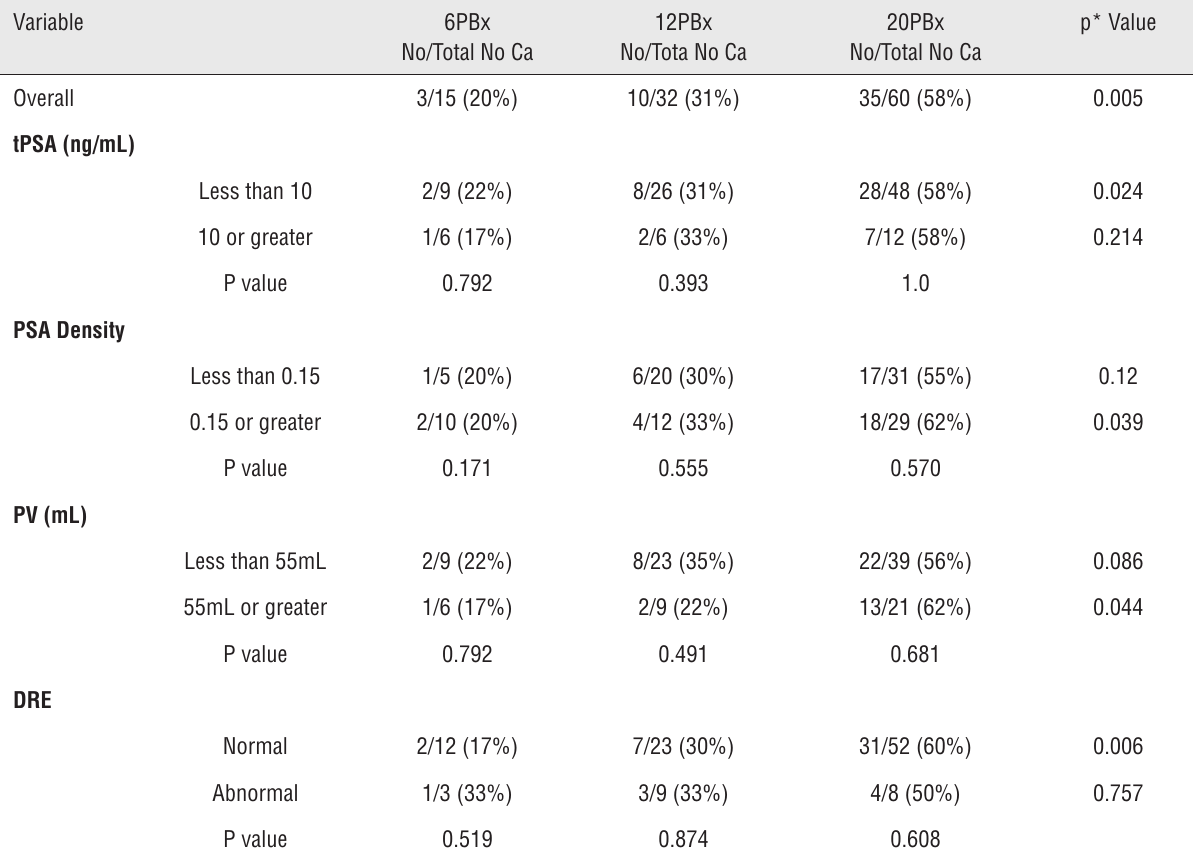
Table 2 - Cancer detection rates according to different parameters. Variable Overall